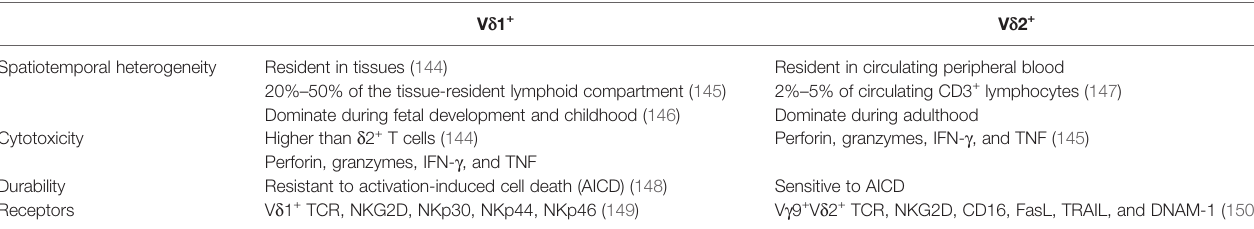
TABLE 5 | Differences between V d 1 + and V d 2 + T